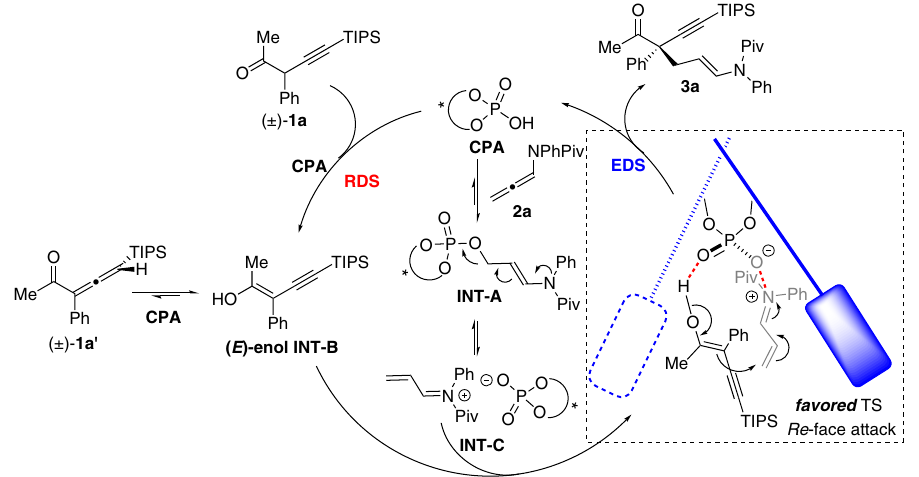
Fig. 7 Proposed reaction mechanism and asymmetric transition state. CPA catalyzed enolization of ketone as the rate-determining step and the conjugate addition with the α , β -unsaturated iminium as the enantio-determining